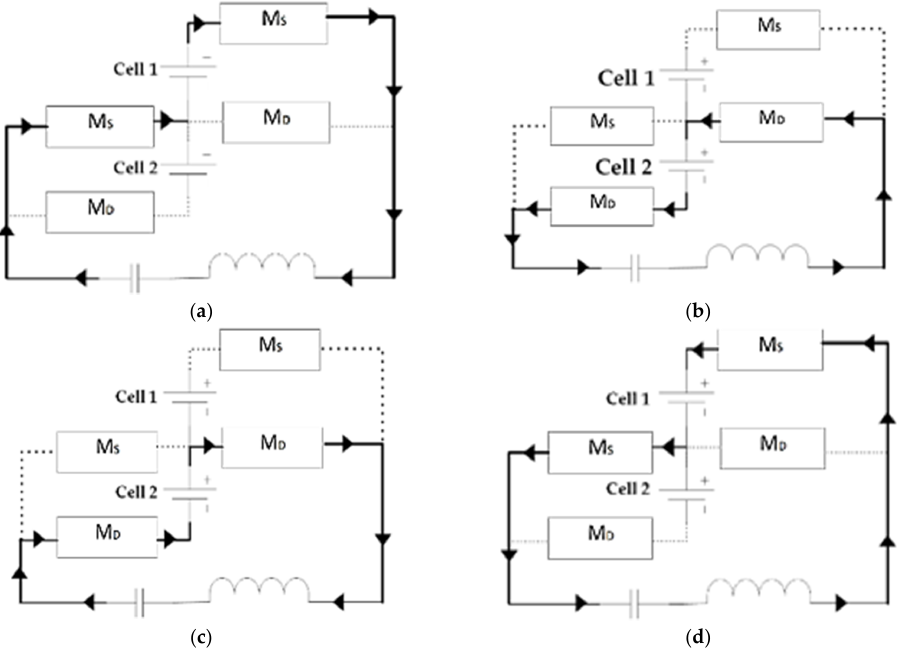
Figure 4. Voltage-balancing process in working mode, ( a ) cell 1 store the energy in LC ; ( b ) LC